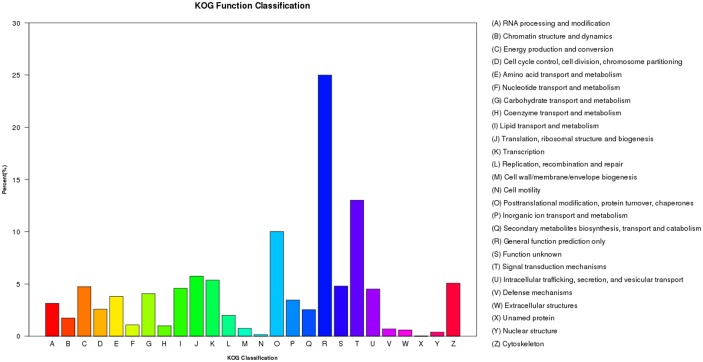
KOG annotations of C. Ciliata predicted proteins.A total of 8,967 predicted proteins have a KOG classification among the 26 categories.